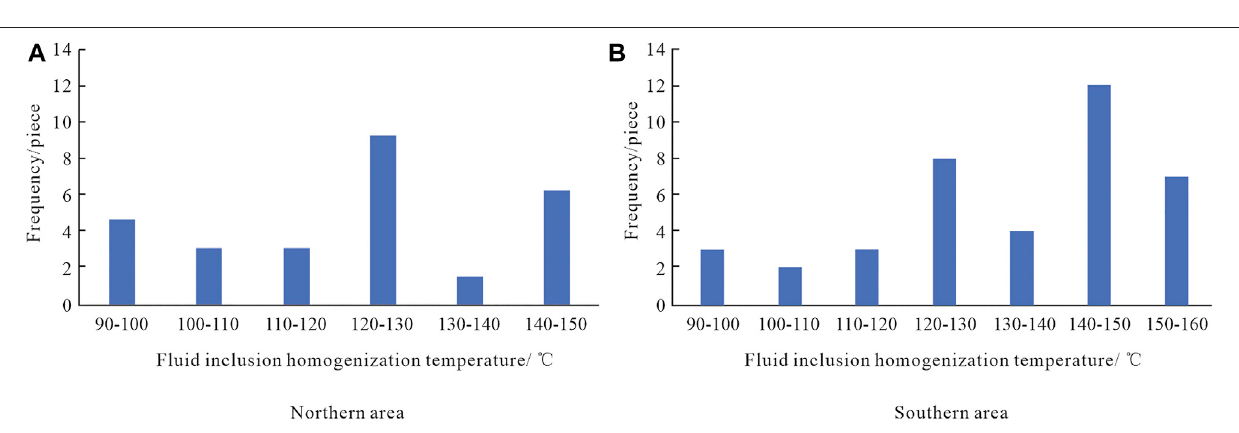
FIGURE 11 | Histogram of aqueous inclusion homogenization temperature of the Xiaoheba Formation; (A) Northern; (B) Southern.